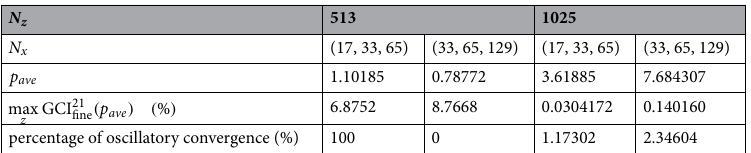
N z , where N x and N z are the number of lattice × 2 π and t = 0.075 for every lattice =